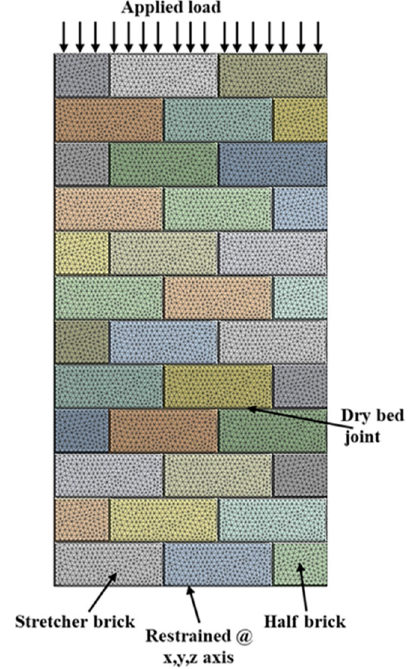
Figure 7. Load and boundary conditions of FE hollow wall.